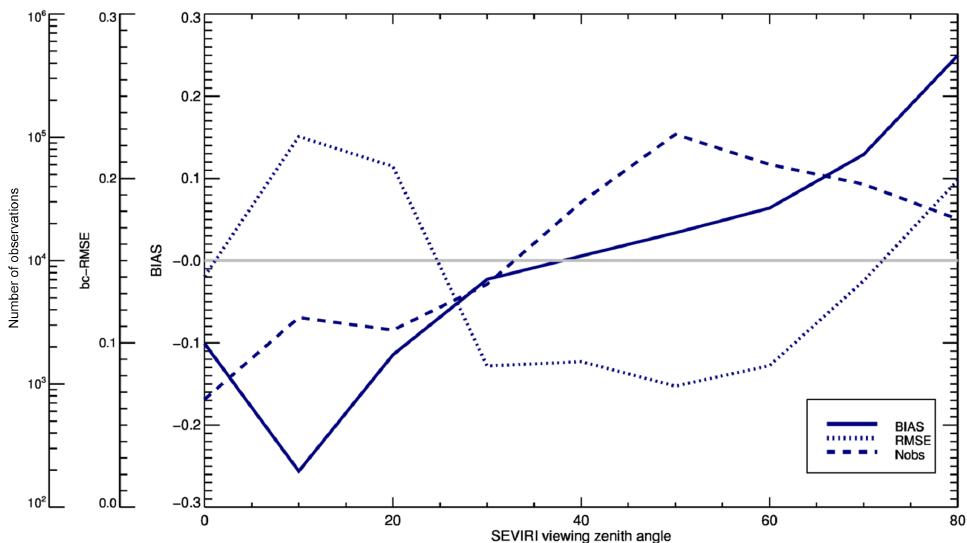
Figure 8. Dependency of the level 3 CLAAS-2–SYNOP CFC bias, bc-RMSE and SYNOP number of observations on the SEVIRI viewing zenith angle.